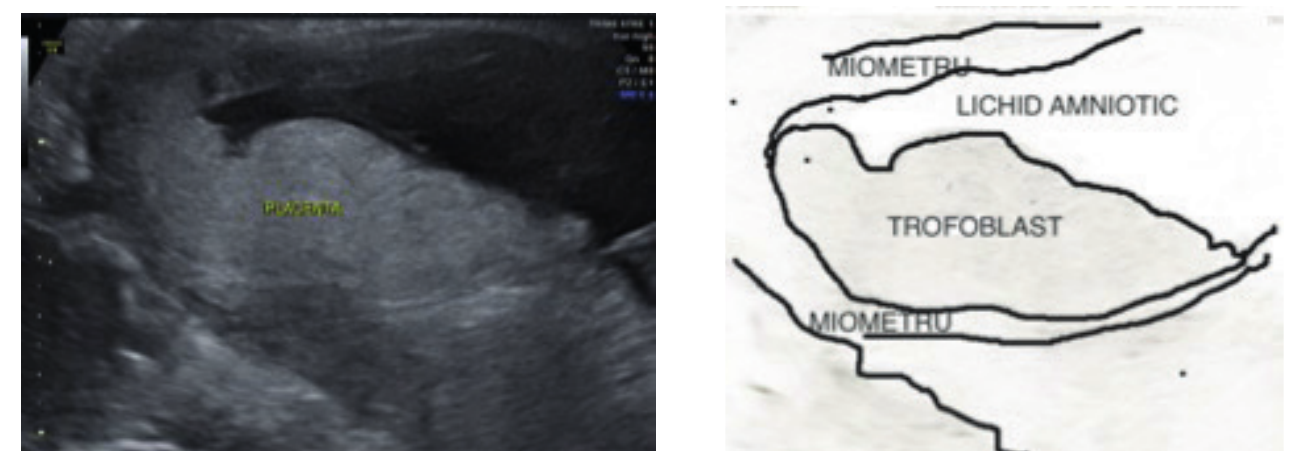
Figure 2 - Transabdominal ultrasound showing normal placenta in the second trimester of pregnancy: granular homogenious echostructure of placenta is well- demarcated from the adjacent miometrium. color Doppler exploration, blood flow